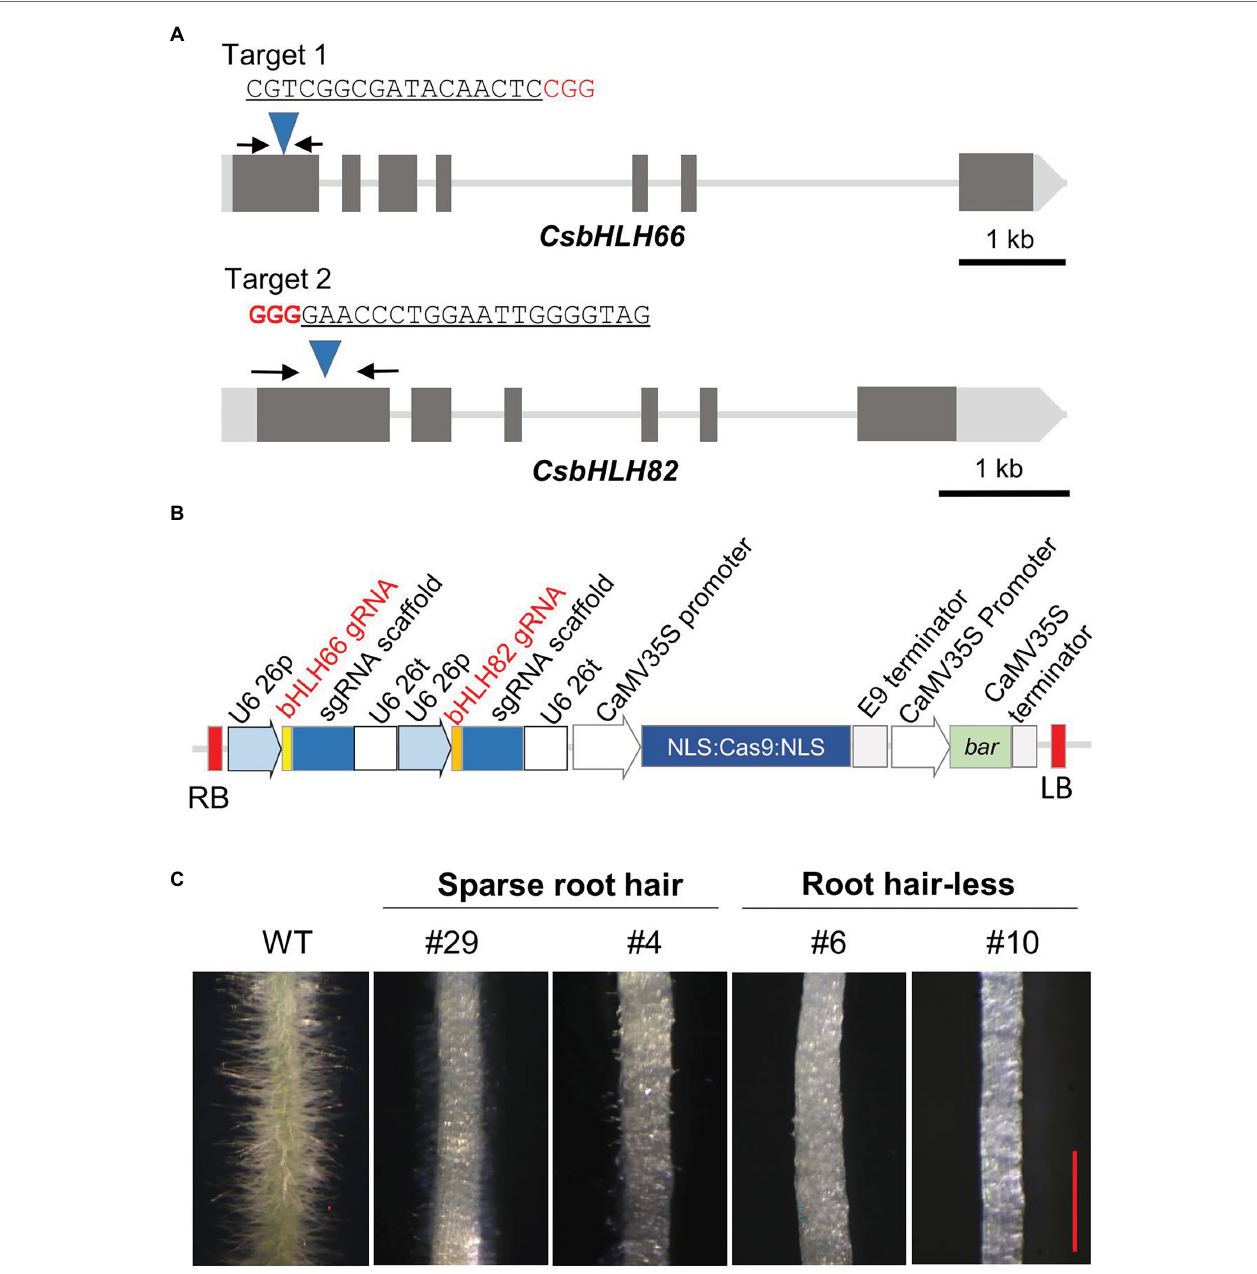
FIGURE 6 | CRISPR/Cas9 construction and phenotyping of mutant hairy roots. (A) Maps of CsbHLH66 , CsbHLH82 genes and target locations. The black arrows indicate primer binding sites for genotyping. (B) T-DNA regions of the CRISPR/Cas9 plant transformation vector. (C) Root hair phenotypes of WT and mutant hairy roots. The red scale bar indicates 1